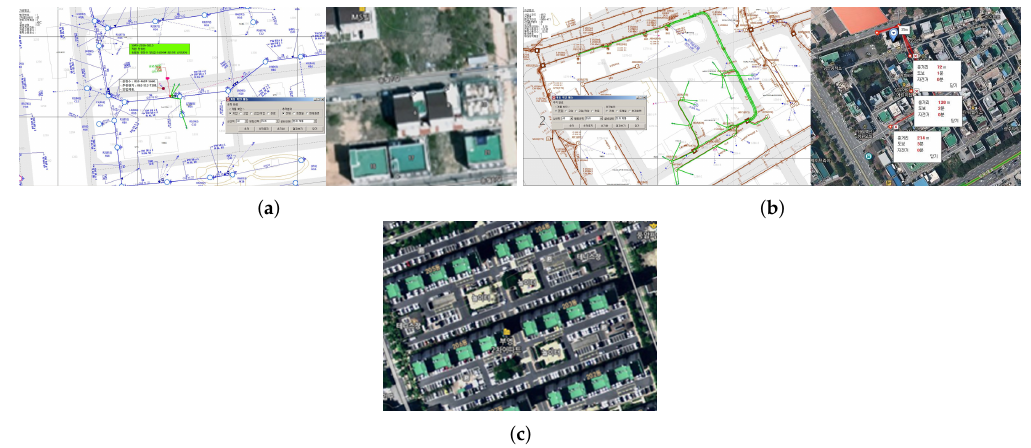
Figure 18. NDIS maps for Underground Area. ( a ) Site 5-1. ( b ) Site 5-2. ( c ) Site